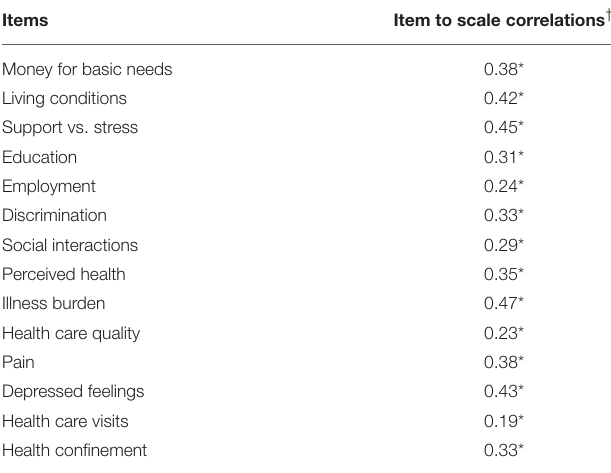
TABLE 4 | Convergent and discriminant validity of item selection for the Duke-PH subscales.